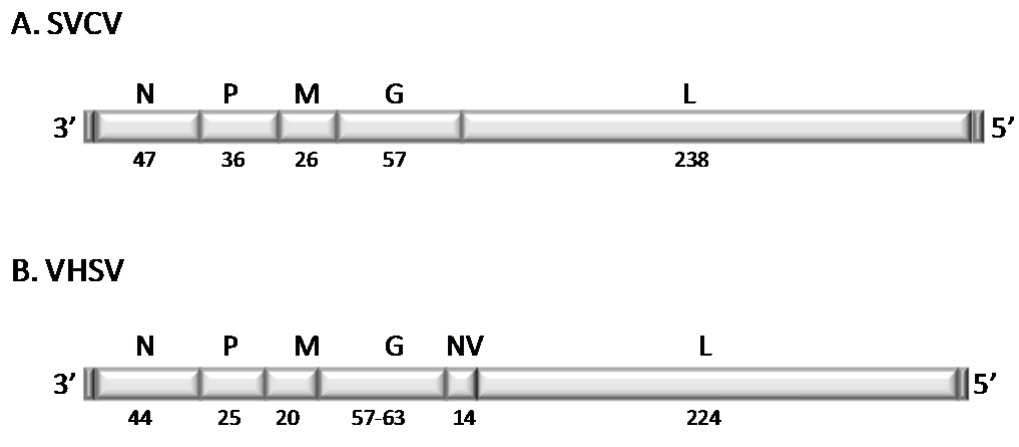
Figure 1. Genome organization and predicted molecular weights (MW) in kilodaltons of ( A ) a typical member of the genus Vesiculovirus , spring viremia of carp virus (SVCV) and ( B ) a typical member of the genus Novirhabdovirus , Viral hemorrhagic septicemia virus (VHSV). Predicted SVCV MW are based on [9] and for VHSV on